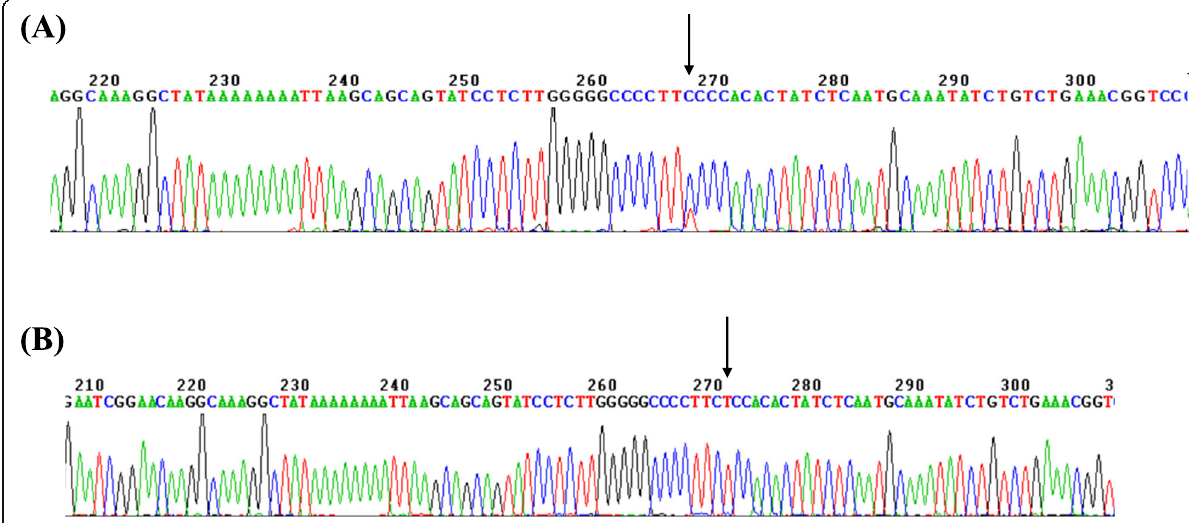
Fig. 5 Chromatograms of point mutations in the proximal fetal γ -globin gene promoters detected in individuals. ( a ) Cretan HPFH ( A γ -197 C-T); ( b ) Homozygote for ( A γ -196 C-T)